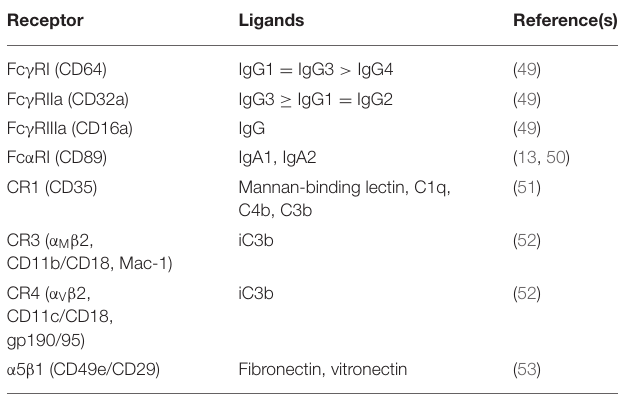
TABLE 3 | Human opsonic phagocytic receptors and their